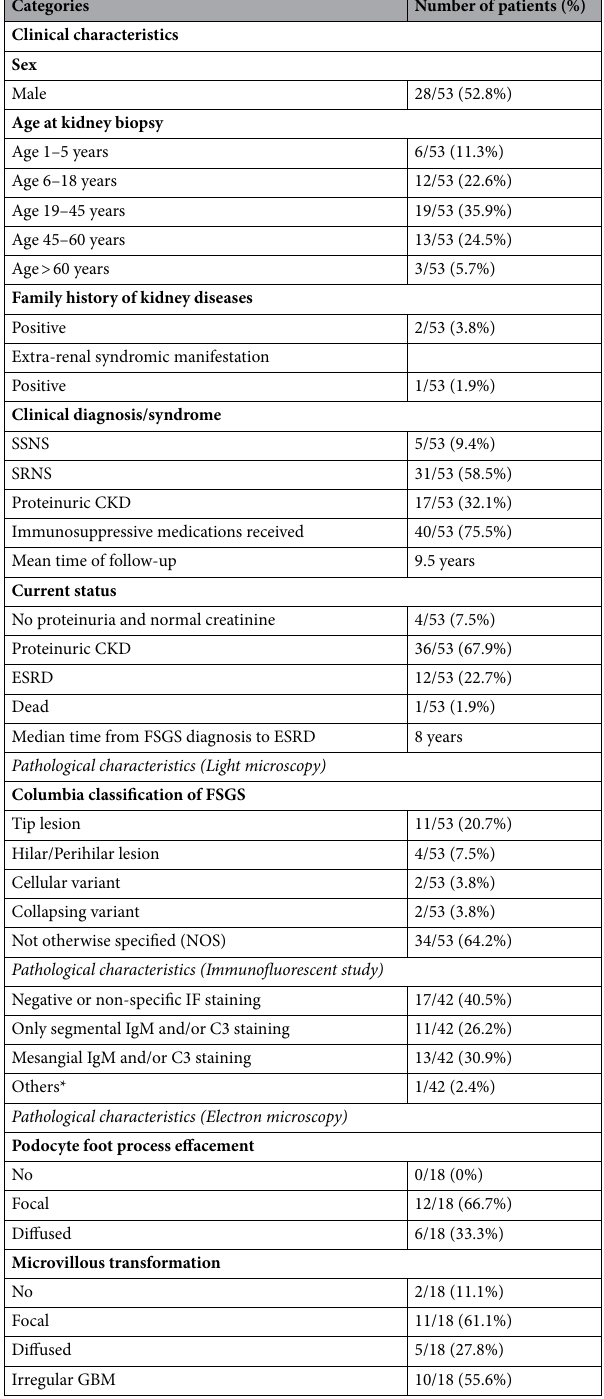
Table 1. Clinical and pathological characteristics of Thai patients with FSGS. CKD chronic kidney disease, ESRD end-stage renal disease, FSGS focal segmental glomerulosclerosis, GBM glomerular basement and lambda along capillary loop with focal linear C3 staining along Bowman’s